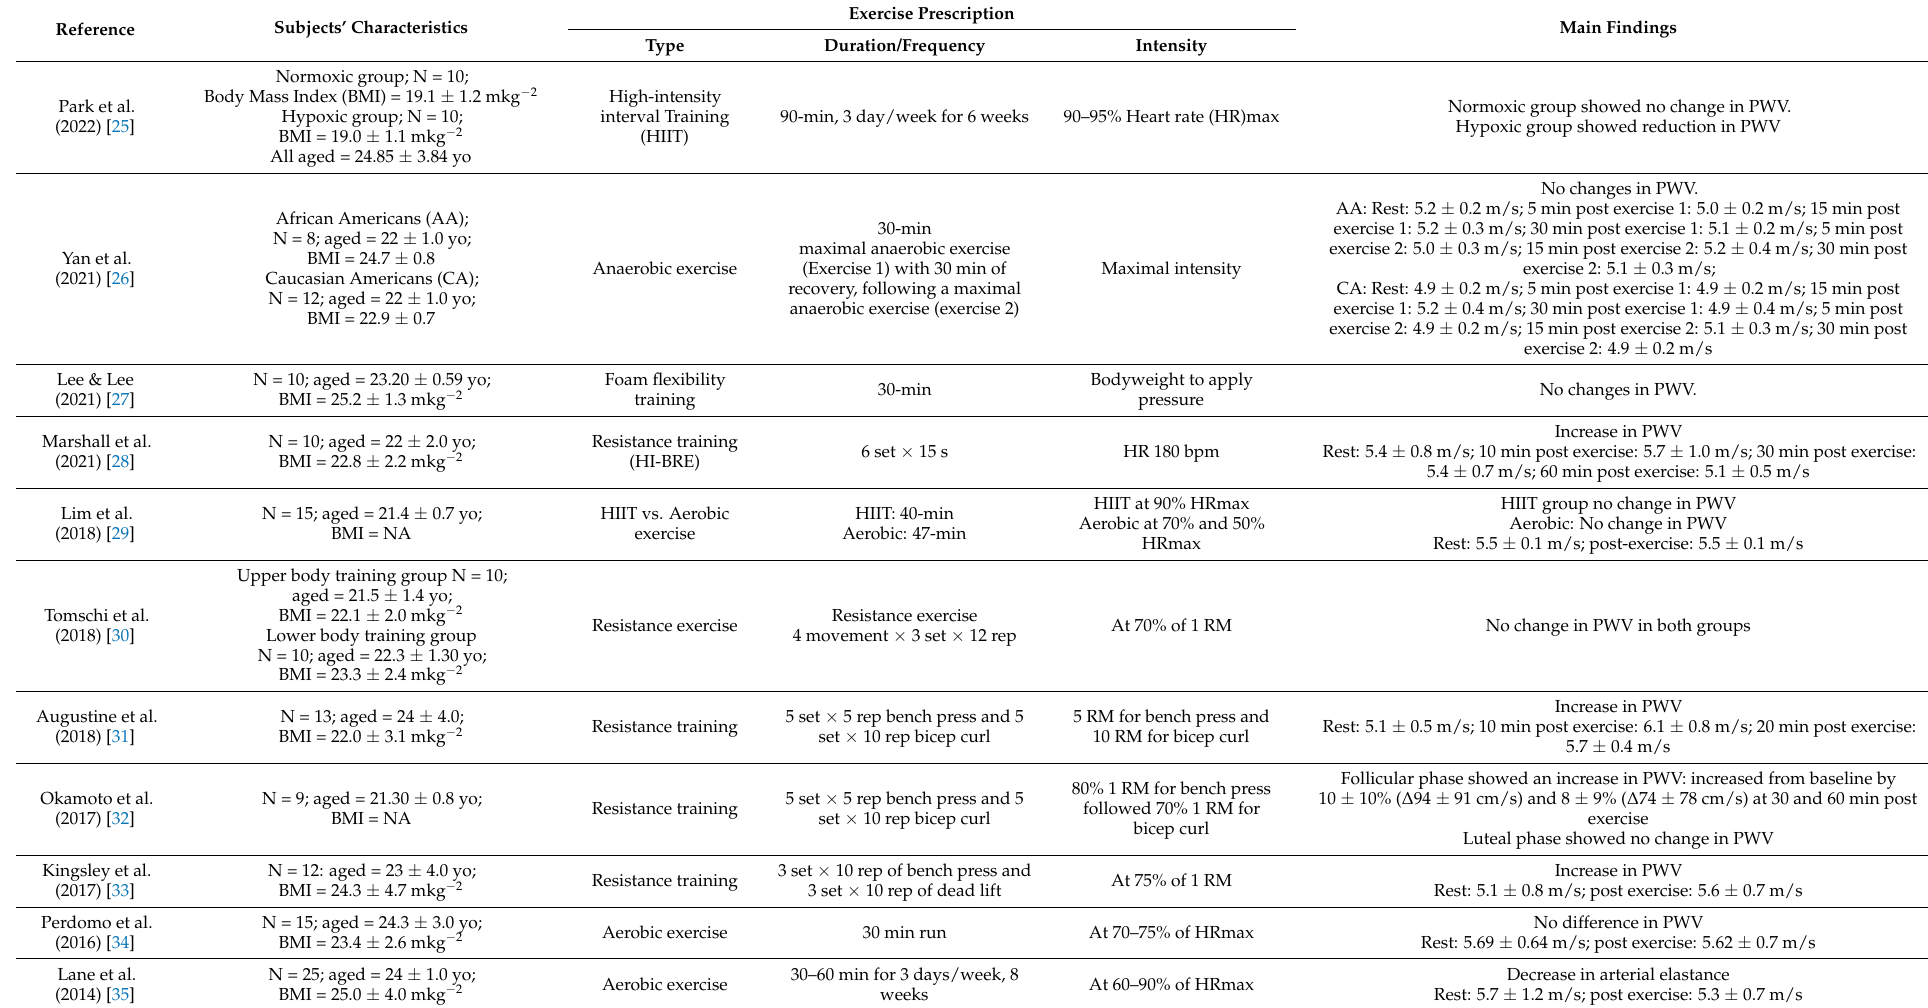
Table 2. Characteristics of selected experimental trials on young women (n =